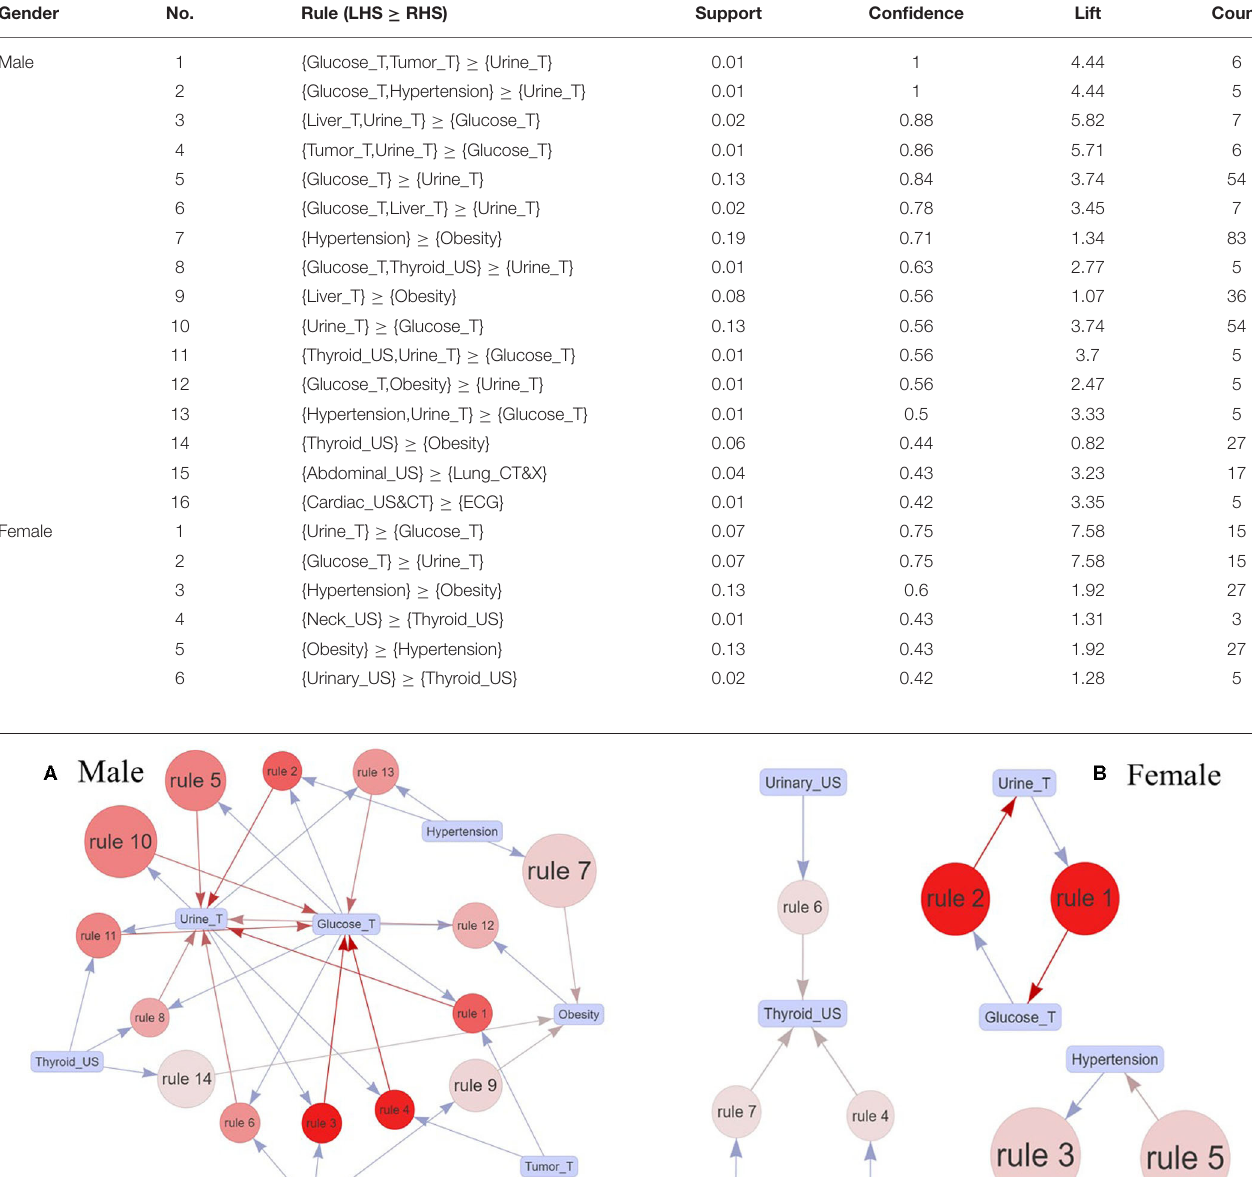
TABLE 7 | The detailed results of the identified effective and strong rules. Gender Support Confidence